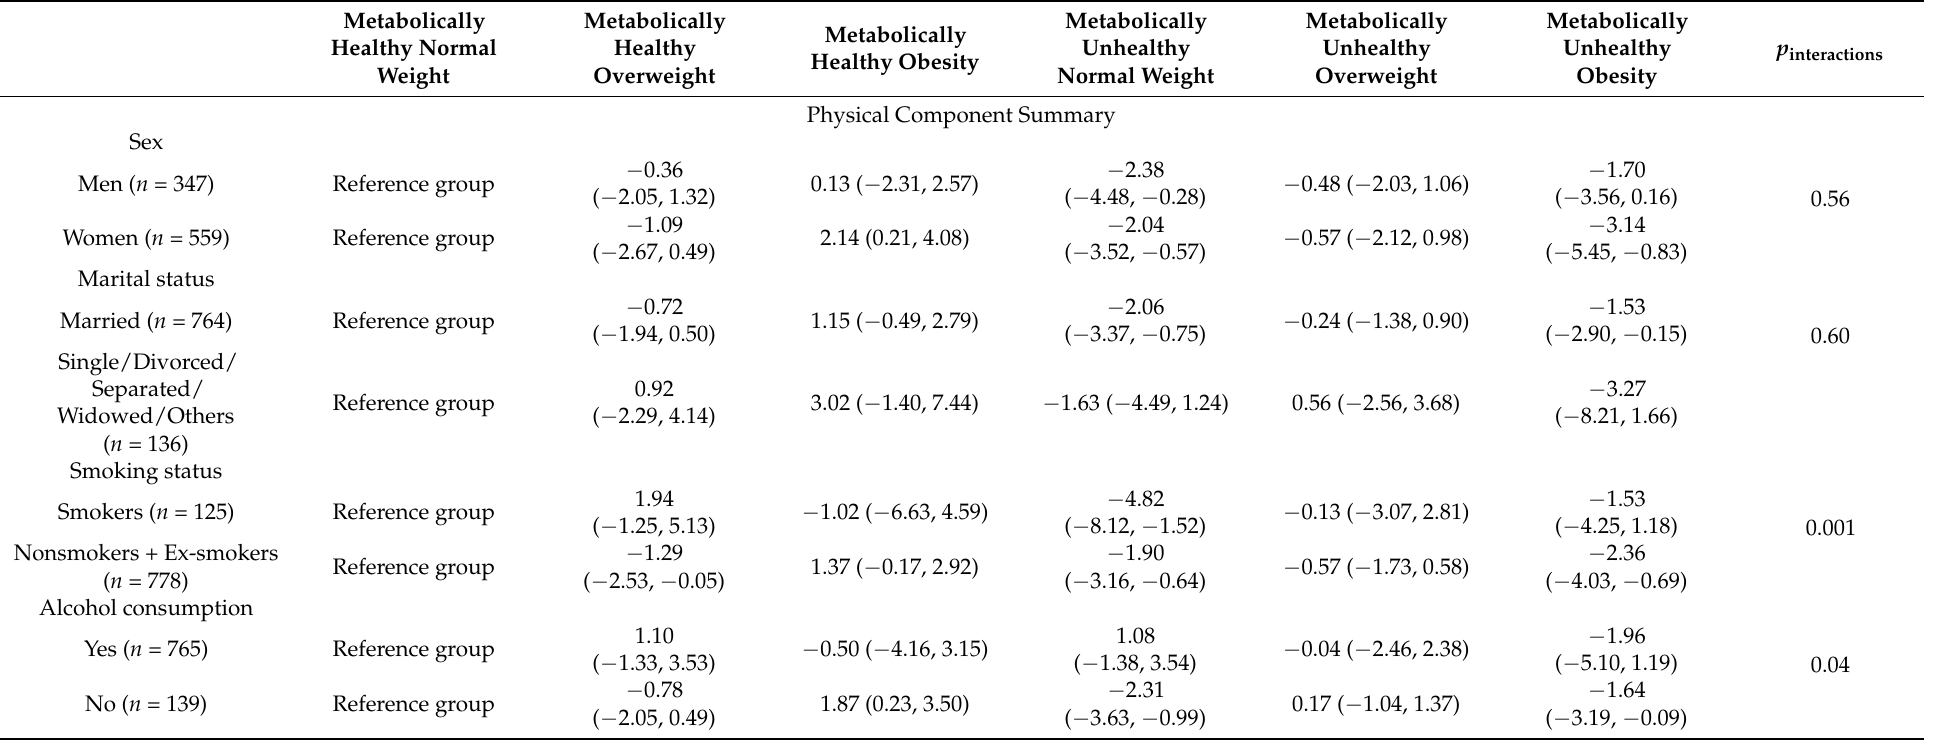
Table 3. The association between metabolic health/BMI groups and health-related quality of life, stratified by sex, marital status, smoking, and alcohol consumption at baseline.